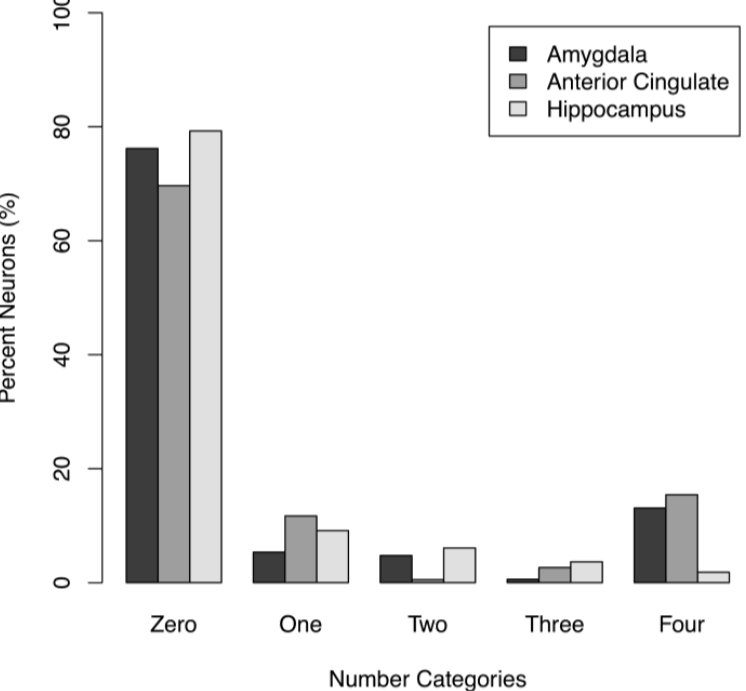
Figure 5. Percentages of neurons that significantly coded different numbers of race categories. The x -axis shows the number of race categories observed per neuron; bar shading indicates brain areas. Amygdala ( n = 168), ACC ( n = 188), Hippocampus ( n = 164). There were no significant proportions of race-predictive neurons in the vmPFC ( n = 105).